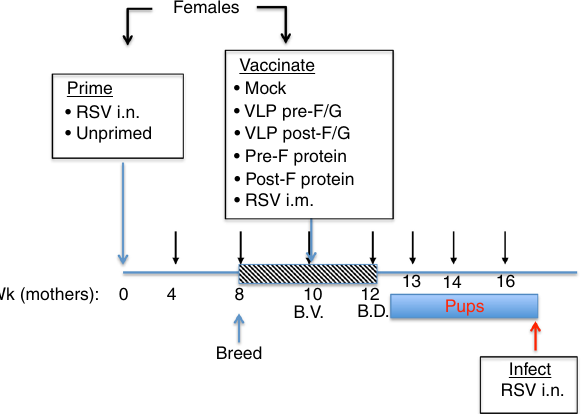
Fig. 1 VLP immunization of naive and RSV-primed female cotton rats. Diagram of the animal protocol. Female cotton rats were primed by